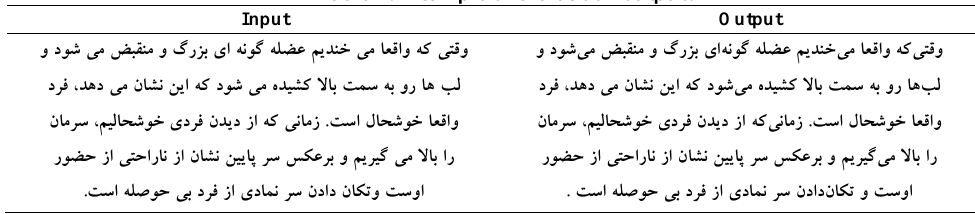
Table 2. A sample of evaluation output.